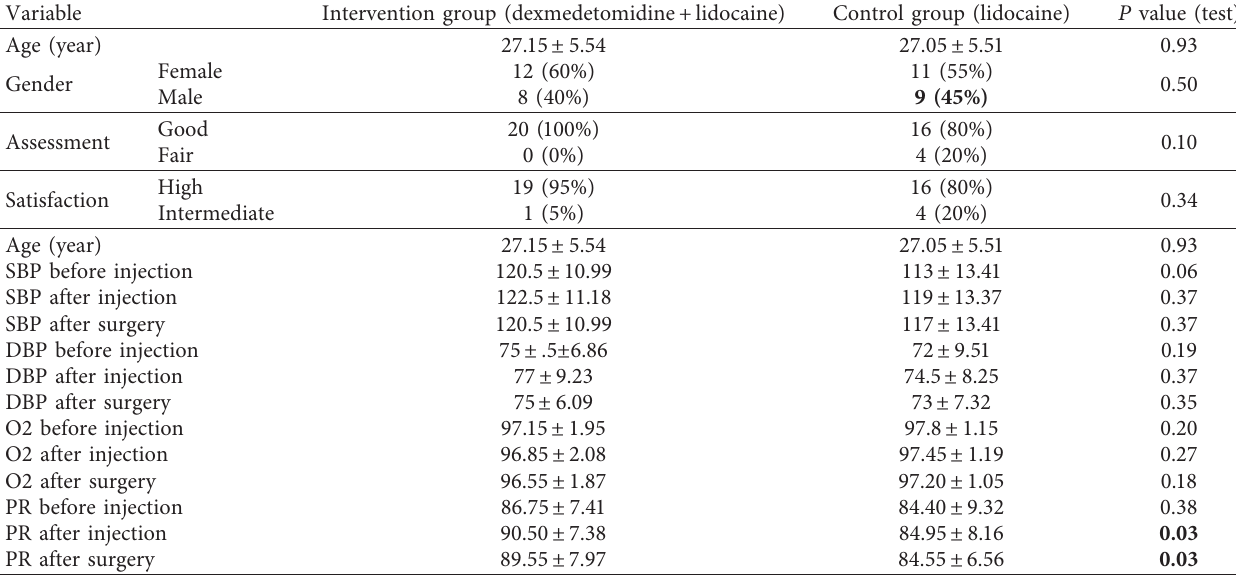
Table 1: Patient characteristics in the intervention and control